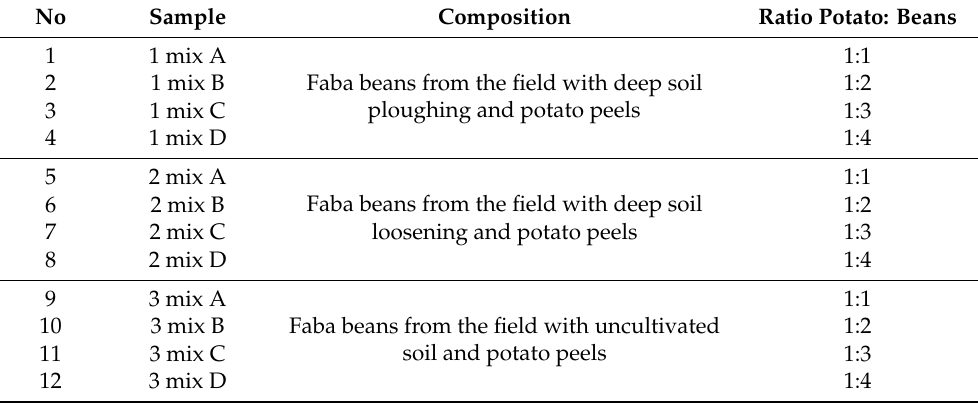
Table 1. Sample collection and